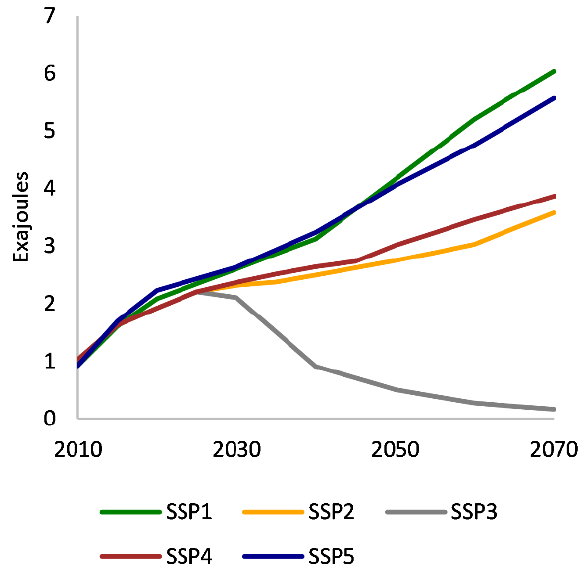
Figure 5. Global secondary energy production for IPCC Shared Socioeconomic Pathways (source: [35]).